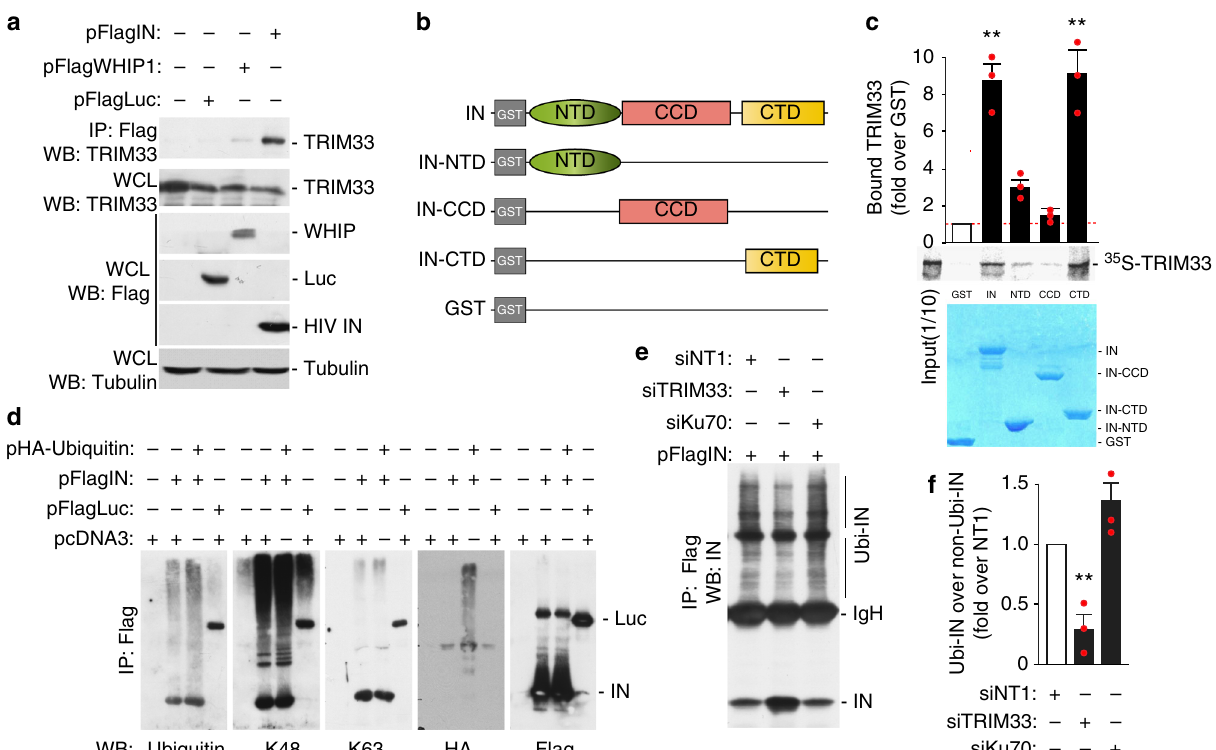
Fig. 4 Cellular TRIM33 binds HIV-1 integrase and regulates its degradation by poly-ubiquitination. a Endogenous TRIM33 interacts with HIV-1 IN in vivo. HEK293T cells were transfected with the plasmids indicated on the top of the panel and immunoprecipitated with anti-Flag M2 beads, followed by immunoblotting with anti-TRIM33 antibody (upper blot). The lower three blots show the levels of expression of the transfected proteins in cell lysates. b Schematic representation of the HIV-1 IN domains used for the pull-down assay in panel c . NTD N-terminal domain, CCD catalytic core domain, CTD C-terminal domain. c TRIM33 binds the HIV-1 IN C-terminal domain (CTD) in in vitro pull-down assay. The indicated fragments of the HIV-1 IN protein fused to GST or GST alone were incubated with in vitro translated [ 35 S]-TRIM33, extensively washed, and then resolved by SDS-PAGE. The middle pictures shows the gel exposed to a phosphoimager from a representative experiment along with the quanti fi cation of the amount of bound proteins expressed as a percentage of radiolabeled input. The lower panel shows the protein gel stained with Coomassie blue to visualize proteins. Quanti fi cation in the upper graph reports mean ± SEM; n = 3 independent experiments; ** P < 0.01; one-way ANOVA. d HIV-1 IN is degraded through Lys48-linked polyubiquitination. HEK293T cells were transfected with Flag-IN and HA-Ubiquitin for 48 h, as indicated. The ubiquitination pro fi le of IN was visualized after immunoprecipitation with anti-Flag M2 beads using anti-ubiquitin, anti-K48, anti-K63, anti-HA, and anti-Flag antibodies. e TRIM33 Inhibition reduces IN polyubiquitination. HEK293T cells were co-transfected with Flag-IN and HA-Ubiquitin for 36 h, as indicated. IN polyubiquitination was visualized after immunoprecipitation with anti-Flag M2 beads using an anti-IN antibody. f Quanti fi cations of the amount of polyubiquitinated IN protein (Ubi-IN) in whole cell extracts, normalized over total IN. Experiments were performed as in panel